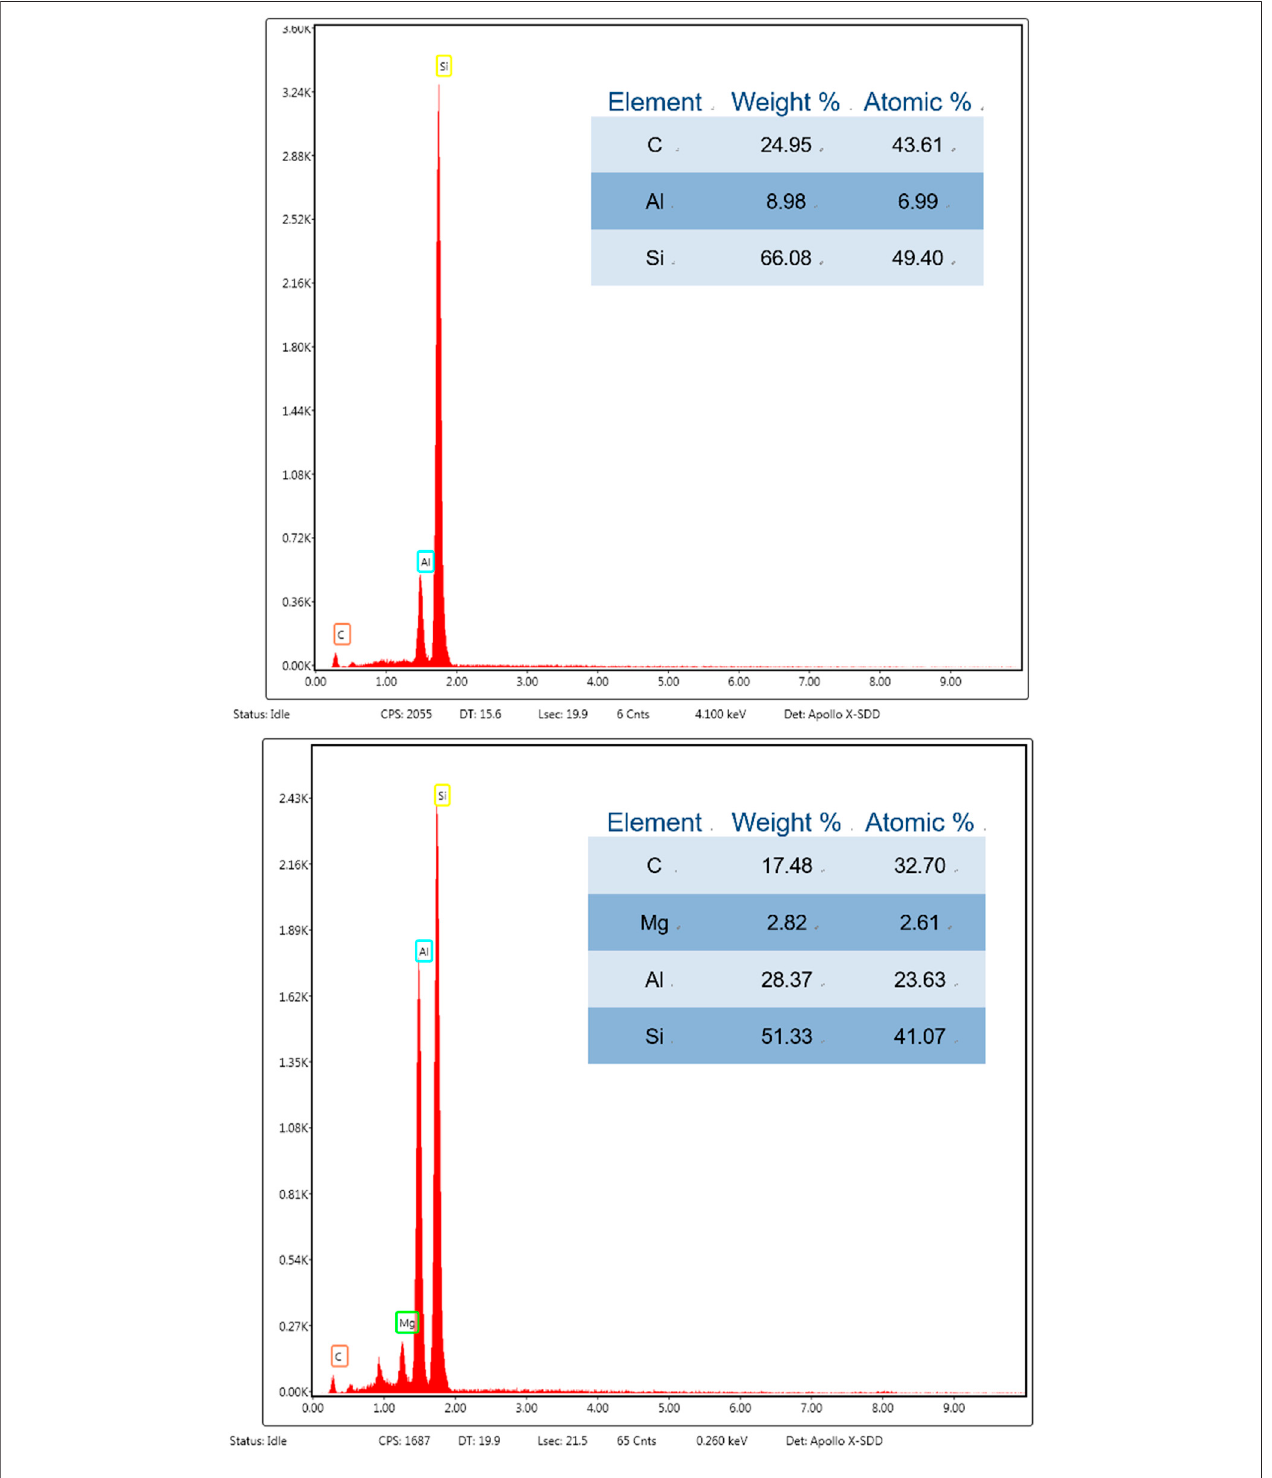
FIGURE 11 | EDS analysis results of regions identi fi ed in Figure 11 .